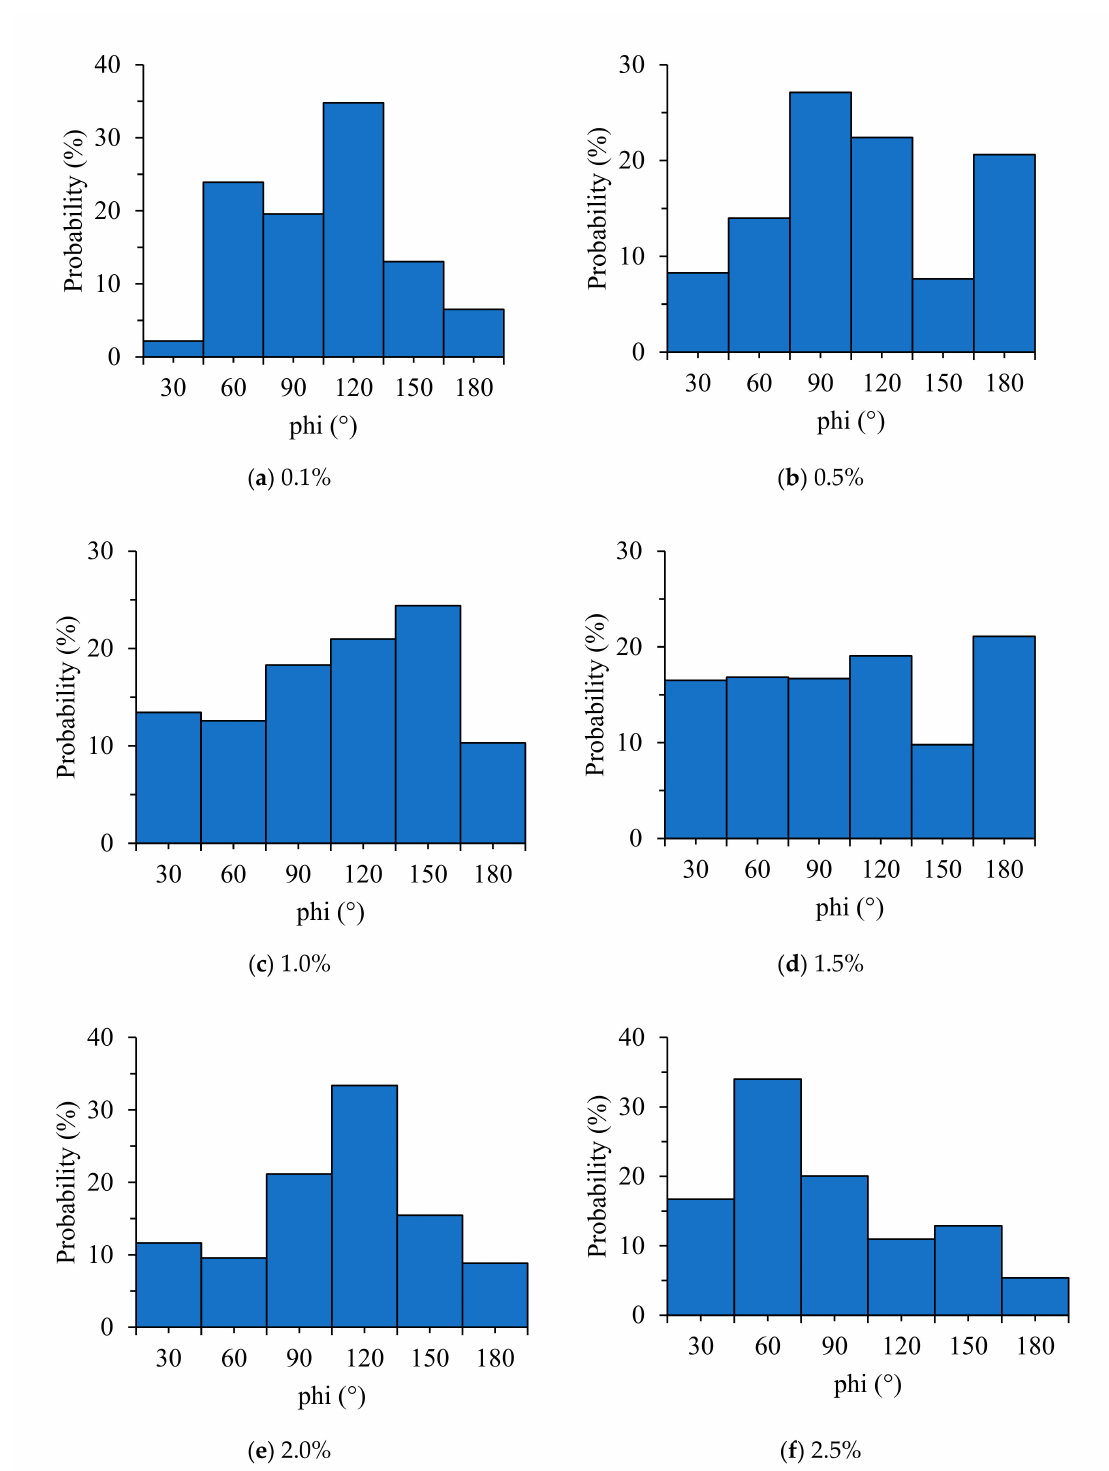
Figure 9. Probability density histograms of the azimuthal angle φ for various fiber